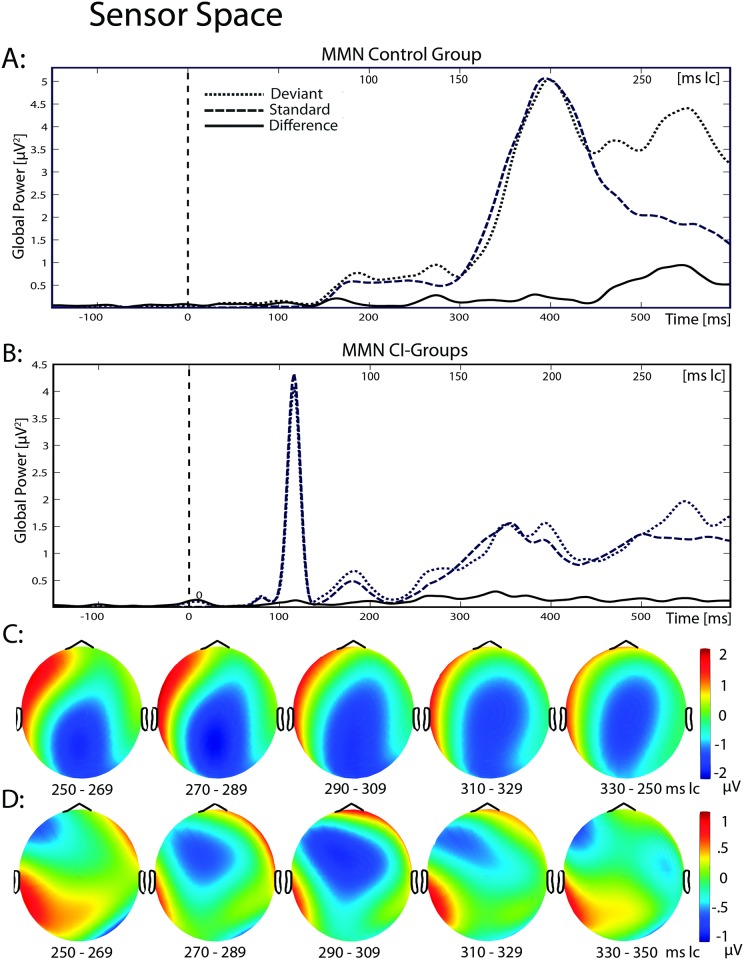
MMN in sensor space.Global power plot for standards, deviants and their difference waveform (deviant minus standard) of the control group (A) and averaged for both CI groups (B). The difference waveform of the controls shows a distinct MMN, with a peak at approximately 280 ms, which was far less prominent in CI users (B). Here, the CI artifact is clearly visible in standards and deviants from 100 to 130 ms, but not in their difference waveform. (C/D): topographic map of the MMN across time with a central negativity displaying the MMN in the control group (C) and–though less pronounced–in CI users (D). Data were assessed with average reference.